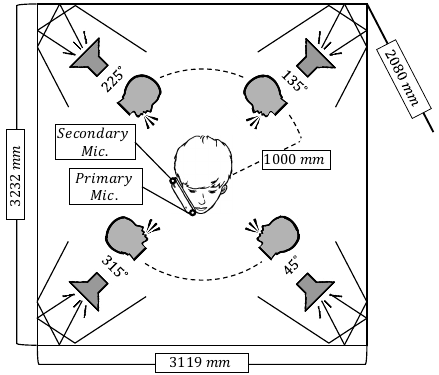
Figure 1. Geographical placement of the noise sources and the